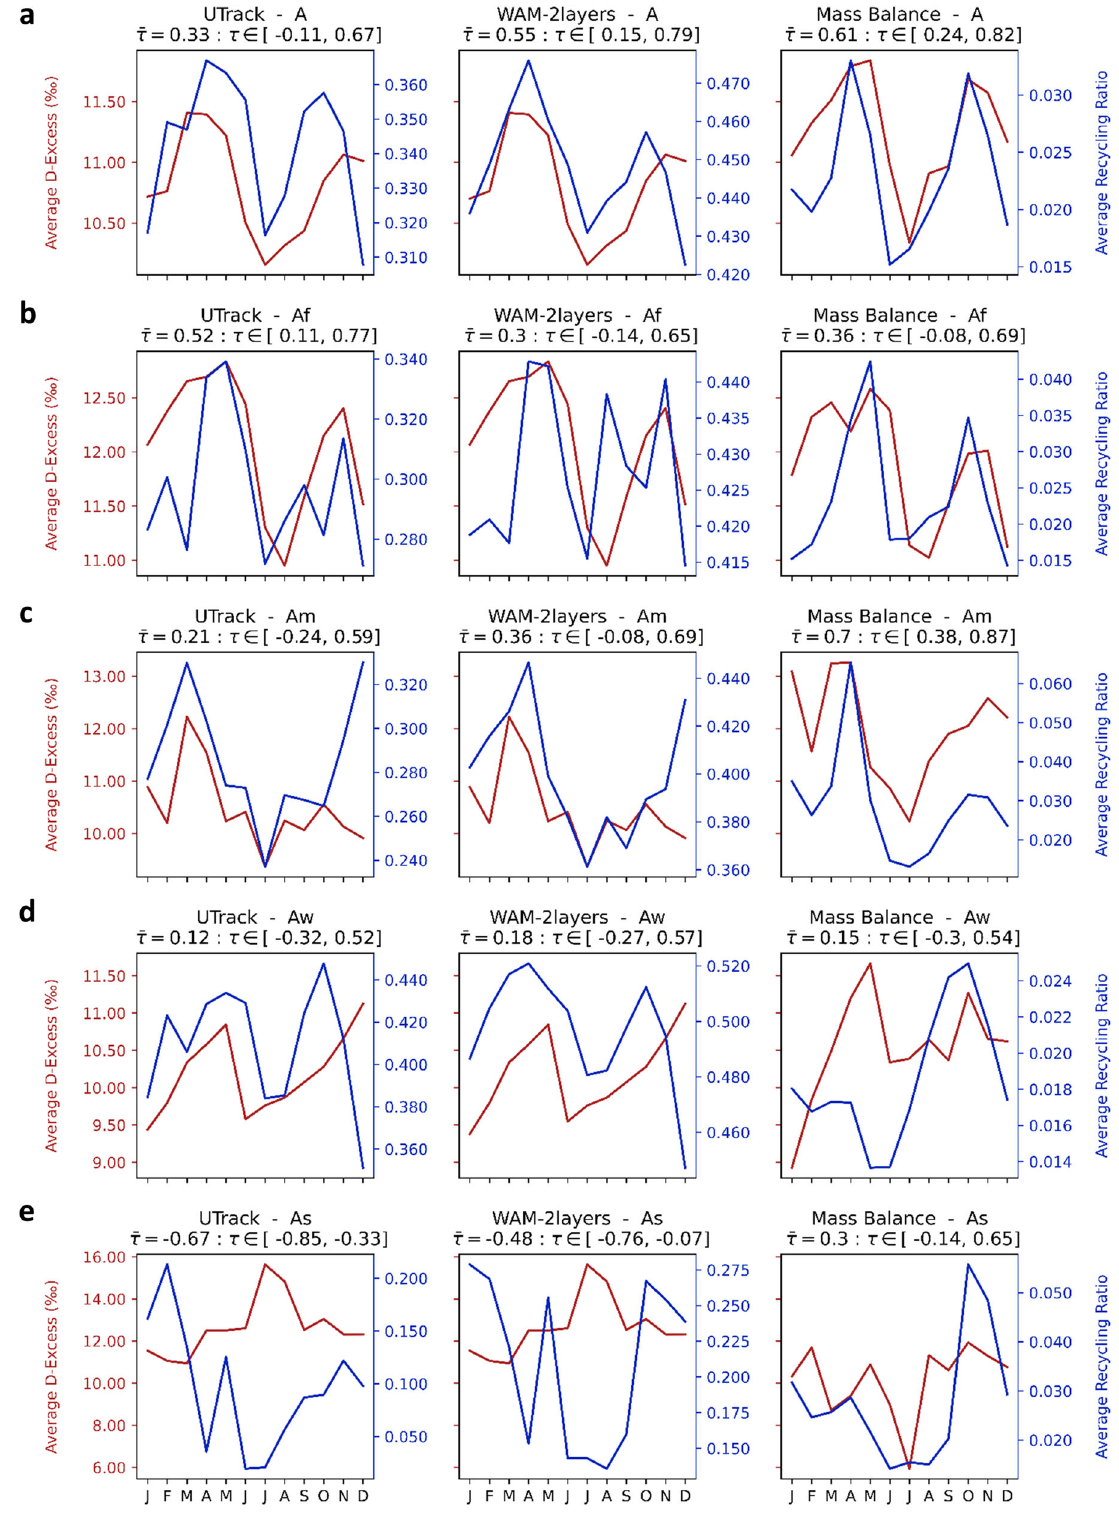
Fig. 3 Climatological cross-comparison of model recycling ratios against observational d-excess values across the tropical region. The mean d-excess value across all stations and years (brown) is compared against the corresponding recycling ratio estimates given by UTrack, WAM-2layers, and Mass Balance models (blue). From top to bottom, the results are arranged by row according to their Köppen – Geiger subzone (A, Af, Am, Aw, As), and the results for each recycling model are given in a new column (UTrack, WAM-2layers, Mass Balance). Kendall ’ s Tau rank cross-correlation coef fi cient is computed between climatological signals of recycling ratio and d-excess. The expected correlation is reported ( τ ) as well as the 95% con fi dence